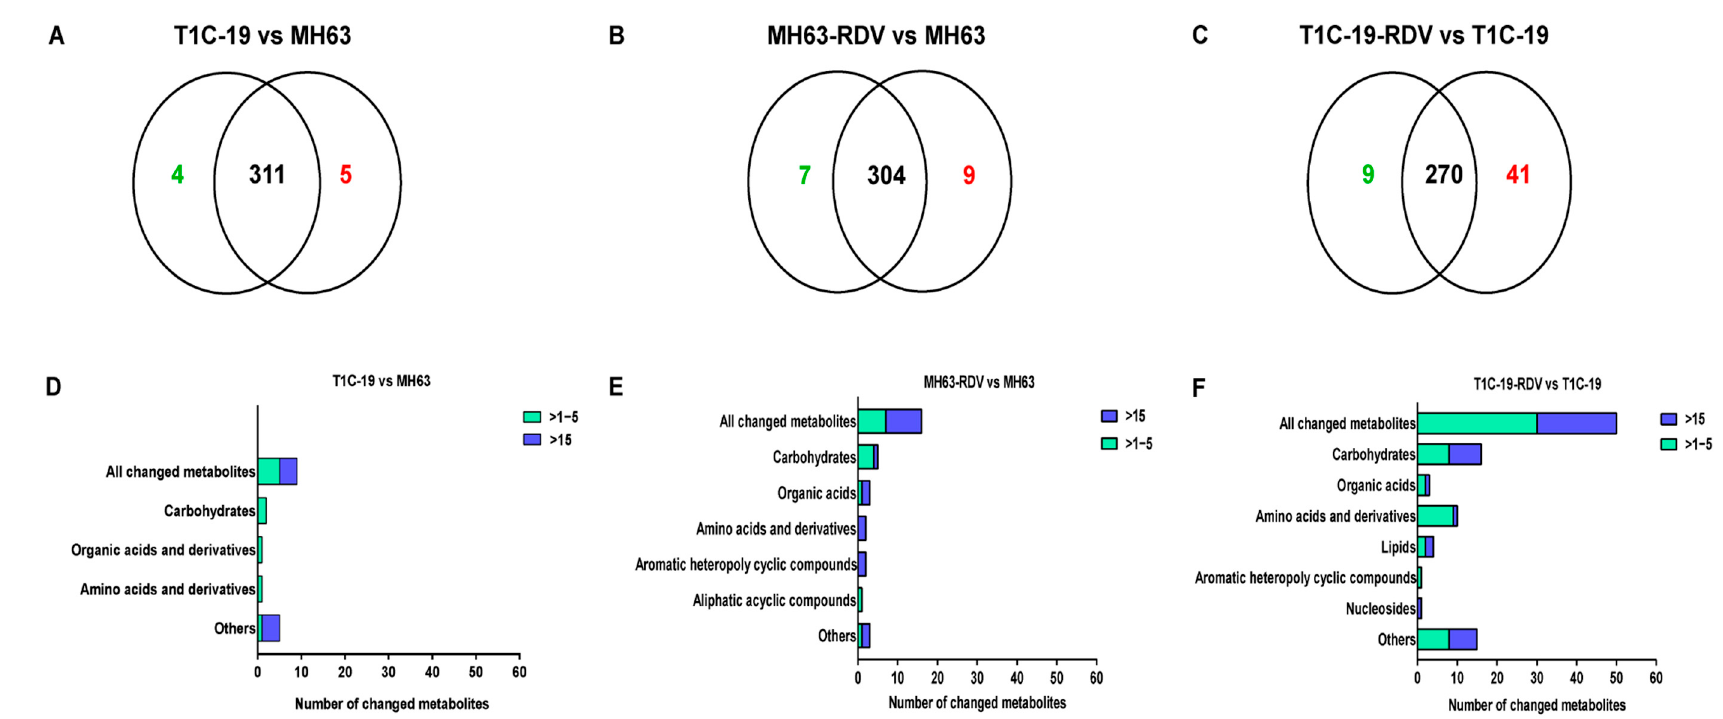
Figure 3. Number of the changed metabolites in three different rice groups. Venn diagrams depicting the changed metabolites between T1C-19 and MH63 rice plants ( A ), between MH63-RDV and MH63 rice plants ( B ), and between T1C-19-RDV and T1C-19 rice plants ( C ). Classification of the changed metabolites and the fold changes between T1C-19 and MH63 rice plants ( D ), between MH63-RDV and MH63 rice plants ( E ), and between T1C-19-RDV and T1C-19 rice plants ( F ).